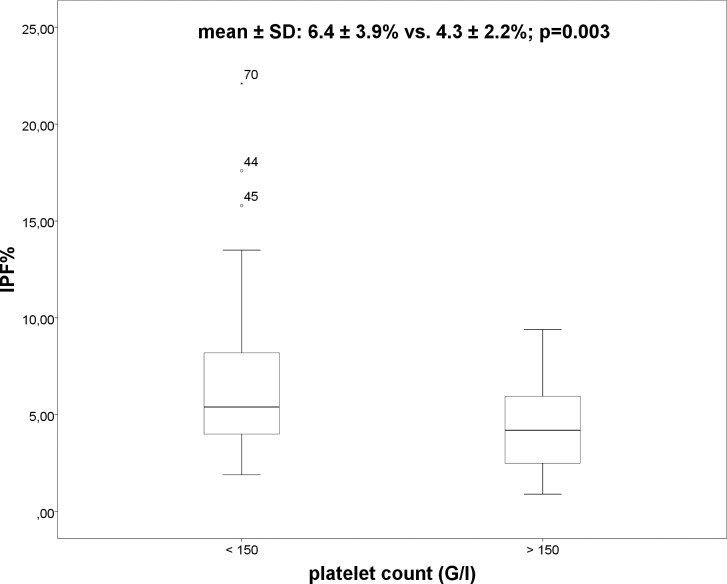
Boxplot: IPF% and platelet count.